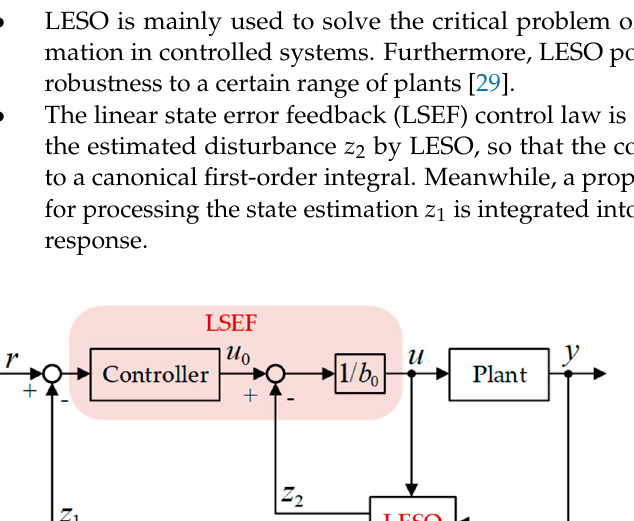
z provides a preliminary 2